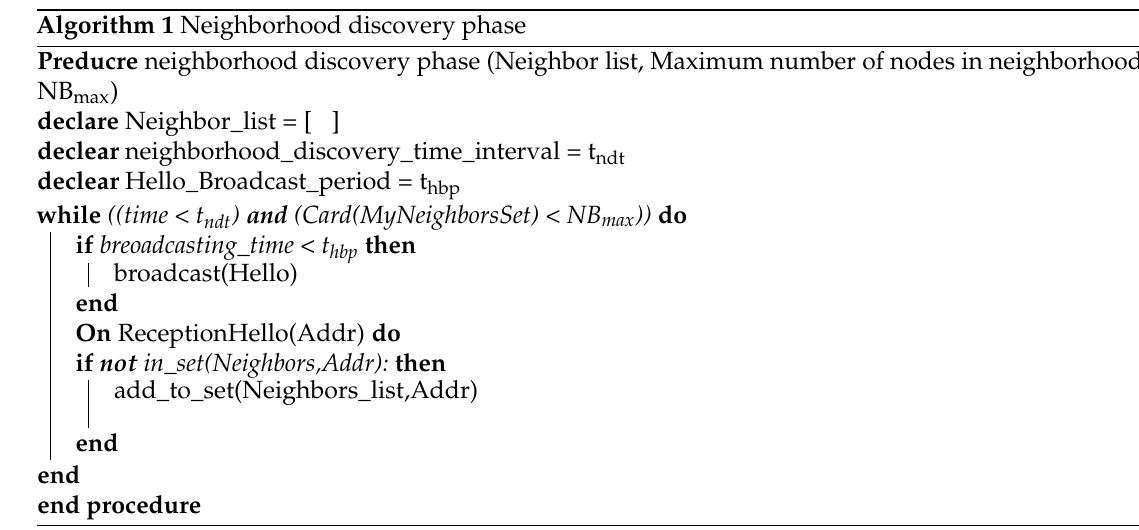
Algorithm 1 Neighborhood discovery phase